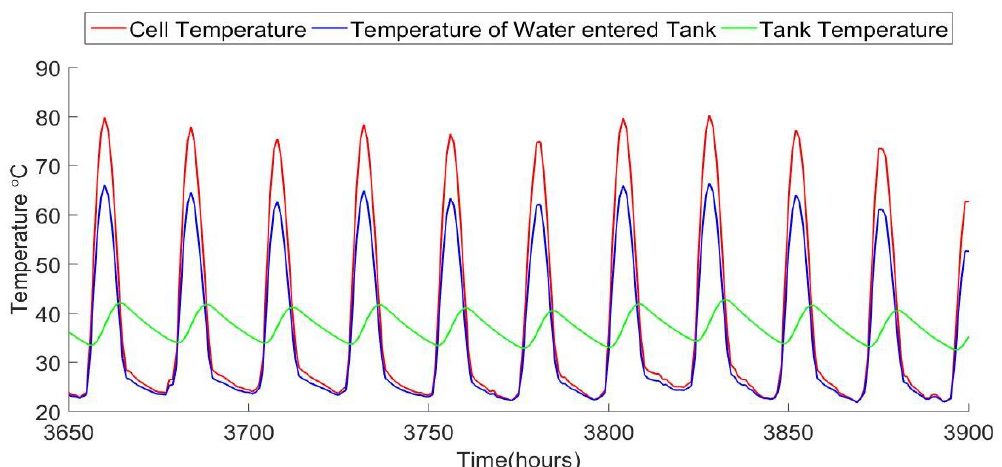
Figure 8. PVT cell temperature and fluid output temperature, along with tank temperature, for several summer days of operation.